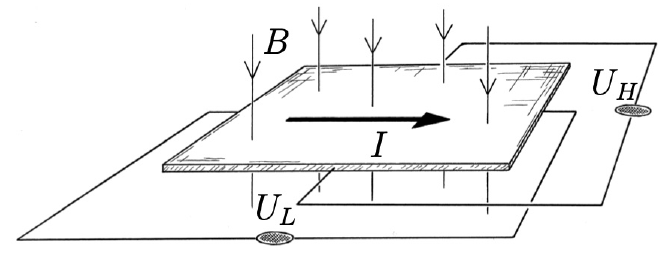
Figure 3: Quantum Hall bar with circuits to measure the longitudinal and transverse voltage drops (Figure thanks to Sören